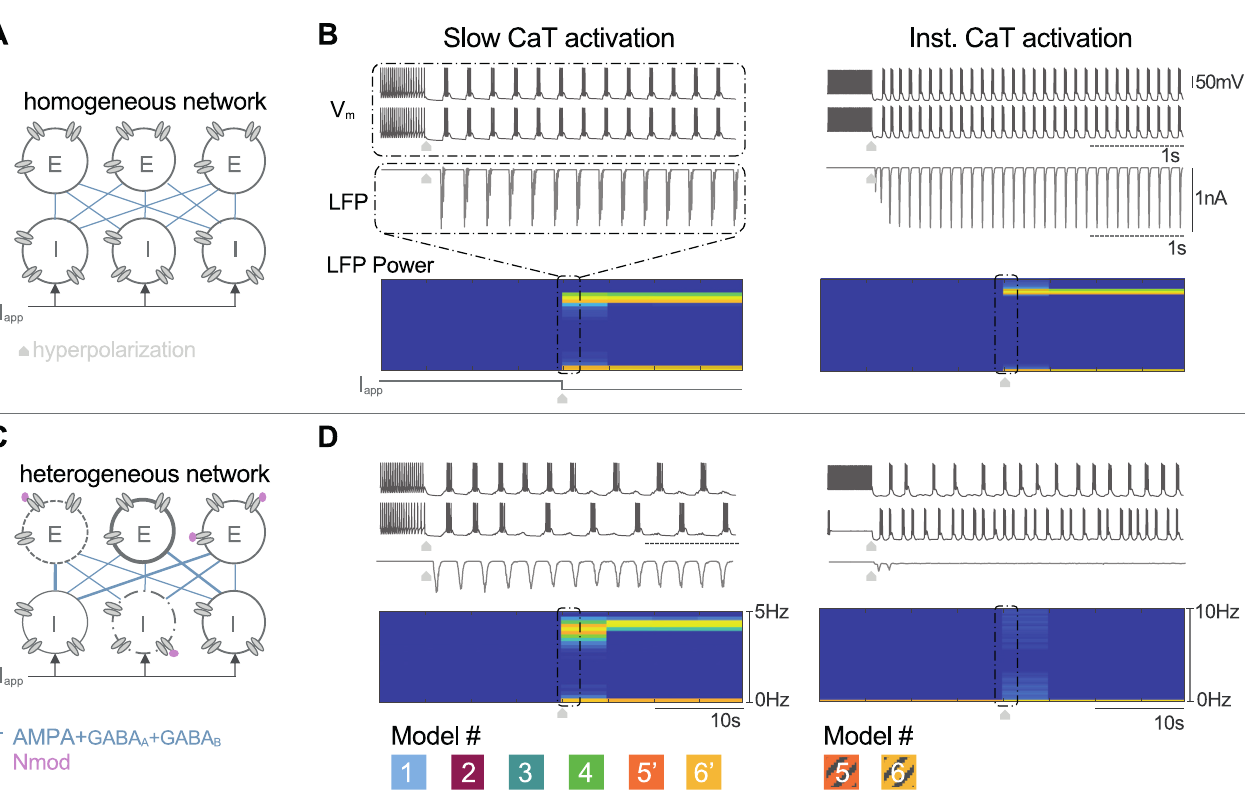
Fig 4. Slow T-type calcium channel activation guarantees robust network switch independent on the population heterogeneity. A : A 200-cell network is built with the same neuron model; 100 excitatory cells connected via the AMPA synapses to 100 inhibitory cells projecting back GABA A and GABA B synapses. The network is homogeneous. All neurons have the same channel densities and the same synaptic weights. B : Voltage traces of two inhibitory cells (two top curves), time-course (third curve) and frequency-time graph (bottom spectrogram) of the local field potentials (LFPs) of the inhibitory neuron population for the homogeneous network. Hyperpolarization of the inhibitory neurons turns on the mean-field rhythm activity of the population depicted by a synchronous bursting at the cellular level, a oscillating synaptic activity shown on the LFP time course whose frequency is shown by the high power LFP frequency band on the spectrogram. C : A heterogeneous 200-cell network is built to take into account neuromodulation, cell variability, more representative topology and synaptic plasticity. Each ionic and synaptic conductance is randomly picked in a given range around its nominal value (see Methods for details). D : (left panel) Only models 1,2,3,4 5’ and 6’ display the switch in the mean field rhythm of the population marked with an oscillatory LFP time-course (third curve) and a significant power band in the spectrogram (bottom). (right panel) Models 5 and 6 that lack slow CaT channel activation are fragile to the network topology and the heterogeneity. Switch in population rhythm is recovered when the slow regenerativity is restored (models 5’ and 6’).